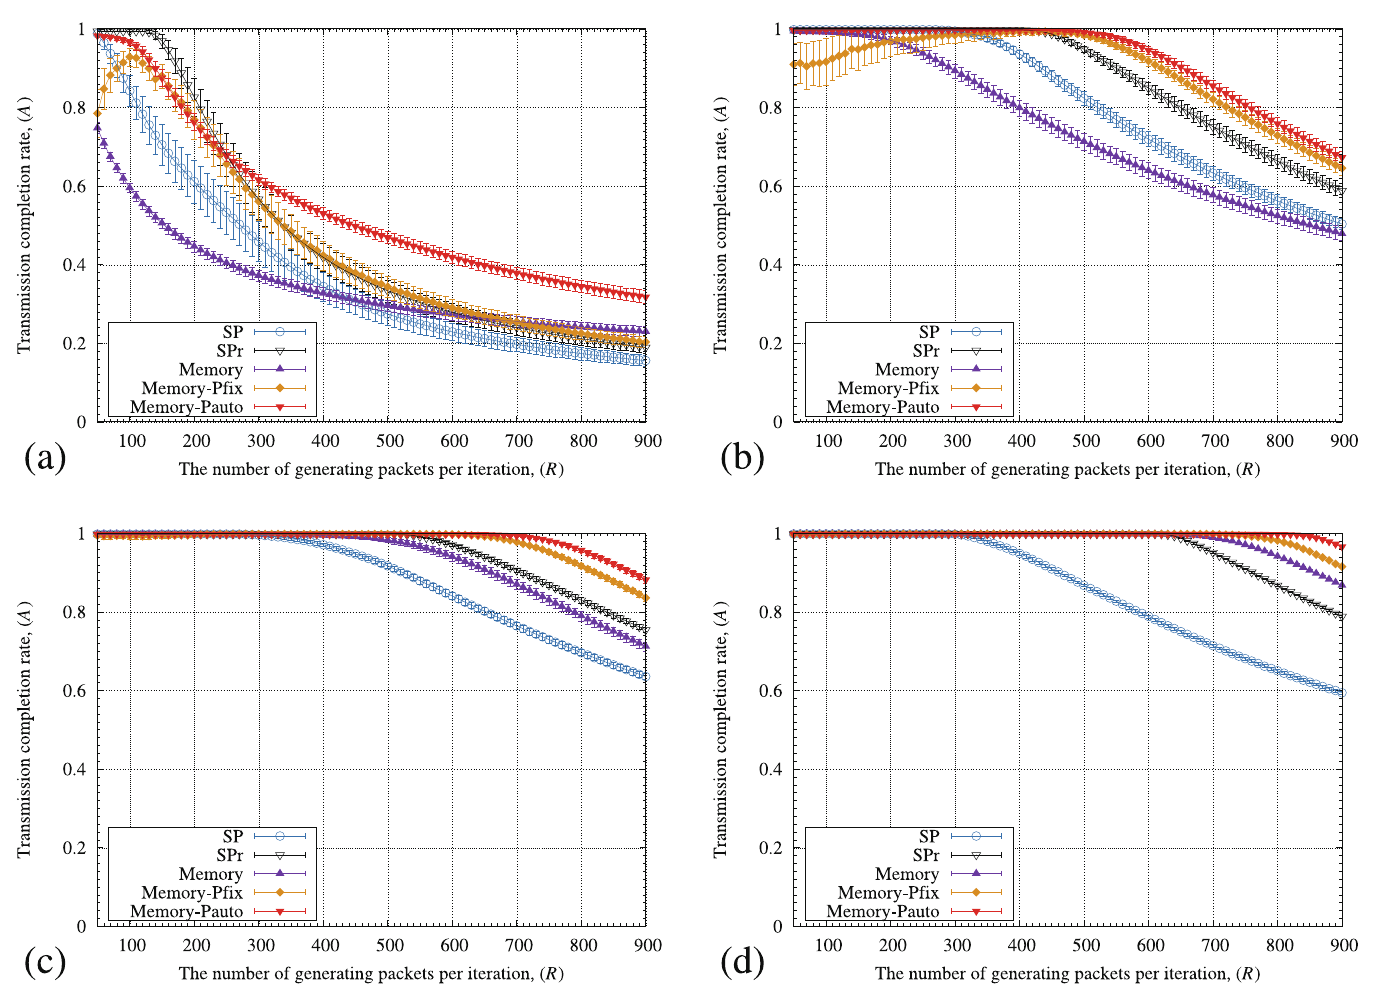
Fig 13. Relationships between the number of generating packets at each iteration ( R ) and a transmission completion rate of arriving packets ( A ) of the SP, SPr, memory, memory-pfix, and memory-pauto methods for the KE model with (a) μ = 0, (b) μ = 0.2, (c) μ = 0.5, and (d) μ = 1. In these figures, the standard deviation of each method is plotted as error